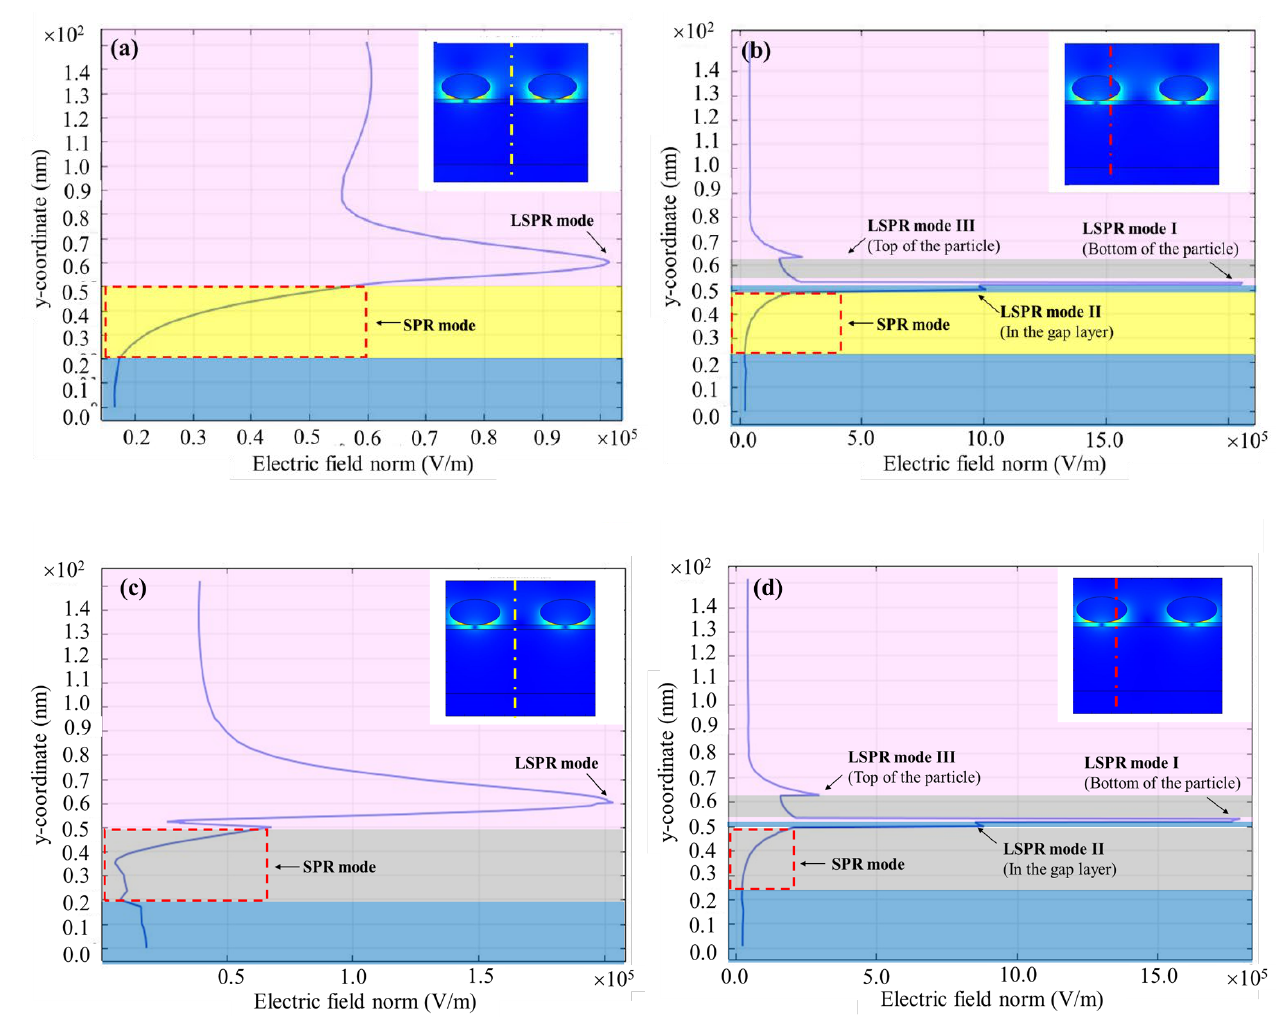
Figure 6. The normal component of the electric field along different axes with metal materials ( a , b ) silver as metal film and gold as metal NPs ( c , d ) silver as metal film and metal